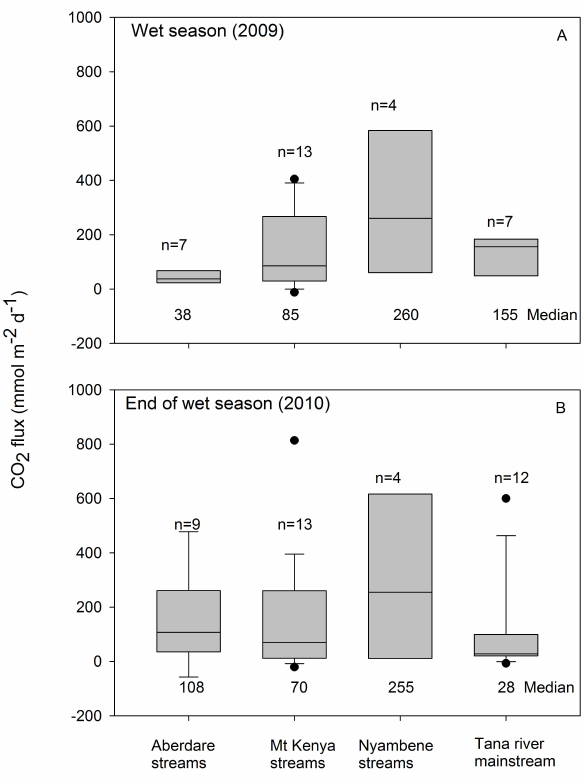
Fig. 7. Boxplots of CO 2 effluxes along the Tana River basin during (A) the wet season, (B) end of the wet season. The centre line, box extent, error bars, and dots denote the 50th percentile, 25th and 75th percentiles, 10th and 90th percentiles, and outliers of estimates, re- spectively.